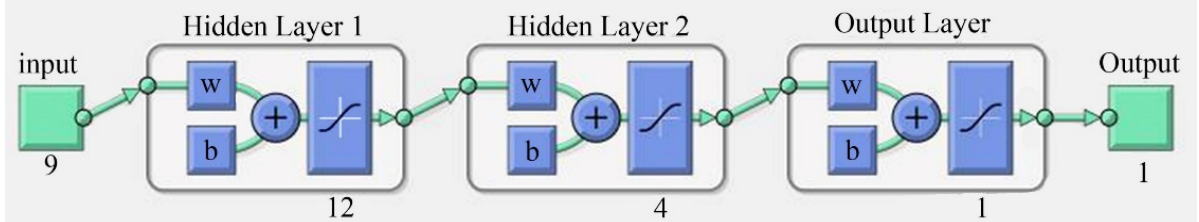
Figure 13. The BP neural network model for predicting the shrinkage tendency of compacted graphite iron.